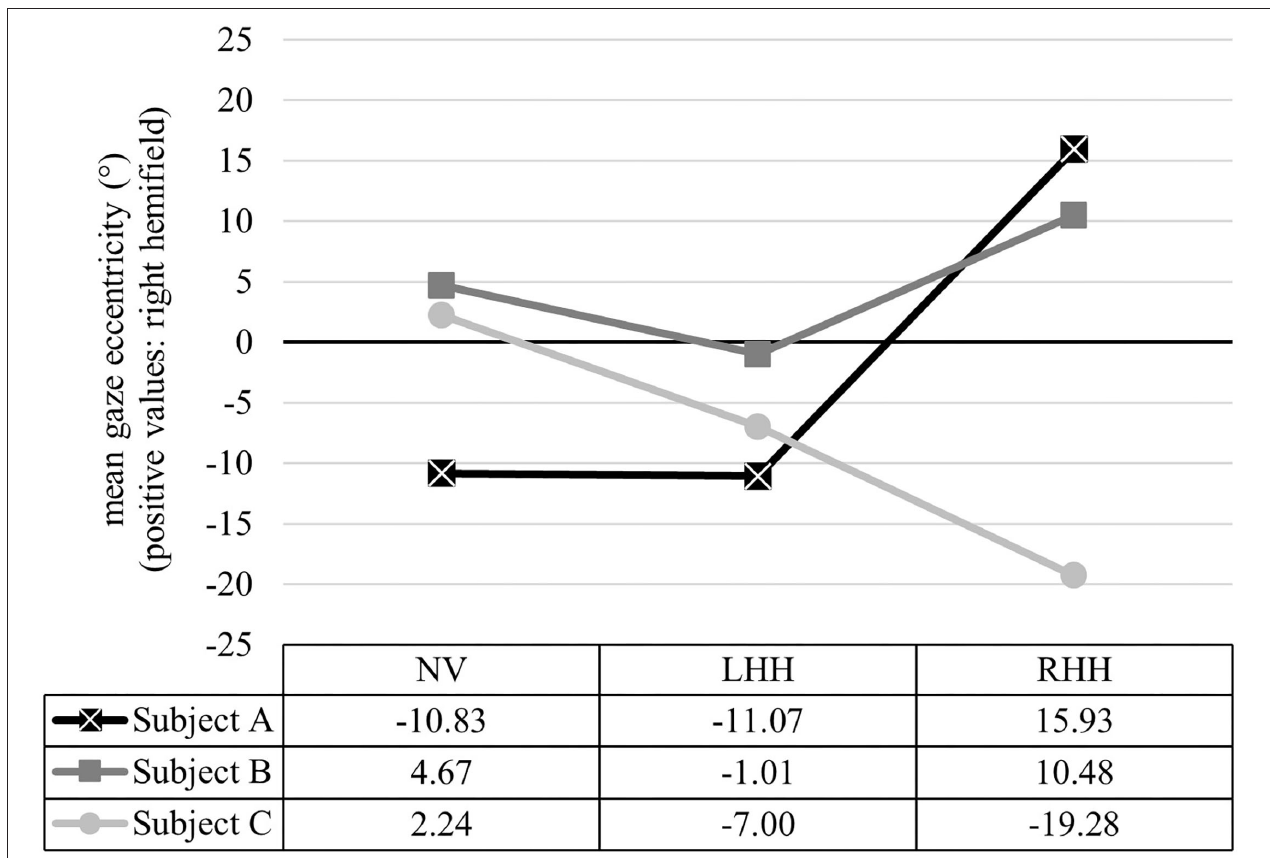
FIGURE 3 | Exemplary data of mean gaze eccentricity for NH, LHH, and RHH for three participants. Relation of intersection conditions showed differing patterns between Subject A (NV = LHH < RHH), Subject B (LHH < NH < RHH), and Subject C (NV > LHH > RHH), reflecting great interindividual heterogeneity. Each data point represents the averaged mean gaze eccentricity over all intersection